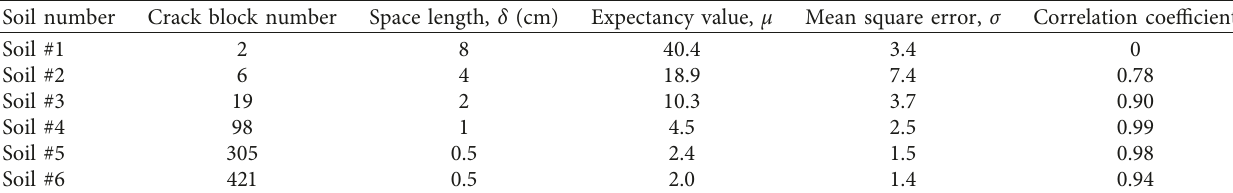
Figure 4: Probability distribution of CB size and its normal distribution fitting results. Table 4: Normal fitting parameters of CB size probability